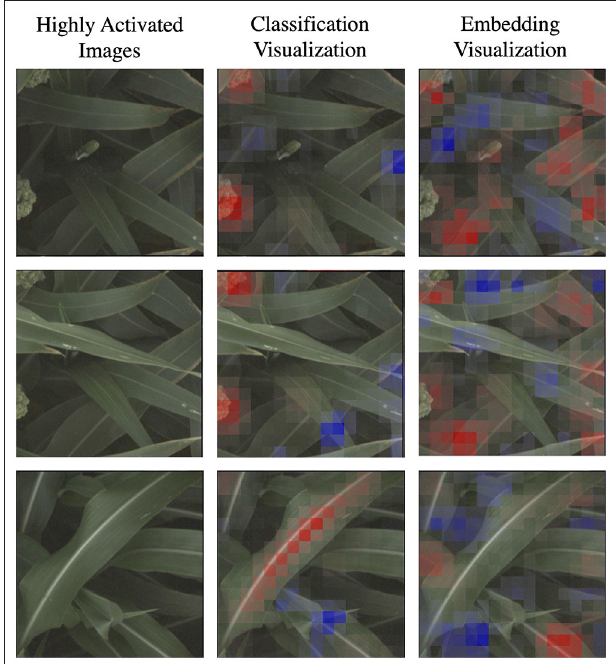
FIGURE 7 | Here we focus on a comparison of the classification and embedding visualizations for highly activated reference images for the d_locus genetic marker family. Features highlighted in red are those that led the network to make its correct classification, while features in blue are those which detracted from the correct classification. This classification visualization clearly highlights specific features such as the panicle or the vein down the center of the leaf, while the embedding visualizations are more diffuse, indicating that the model achieves its higher accuracy by learning more varied (but less readily interpretable)